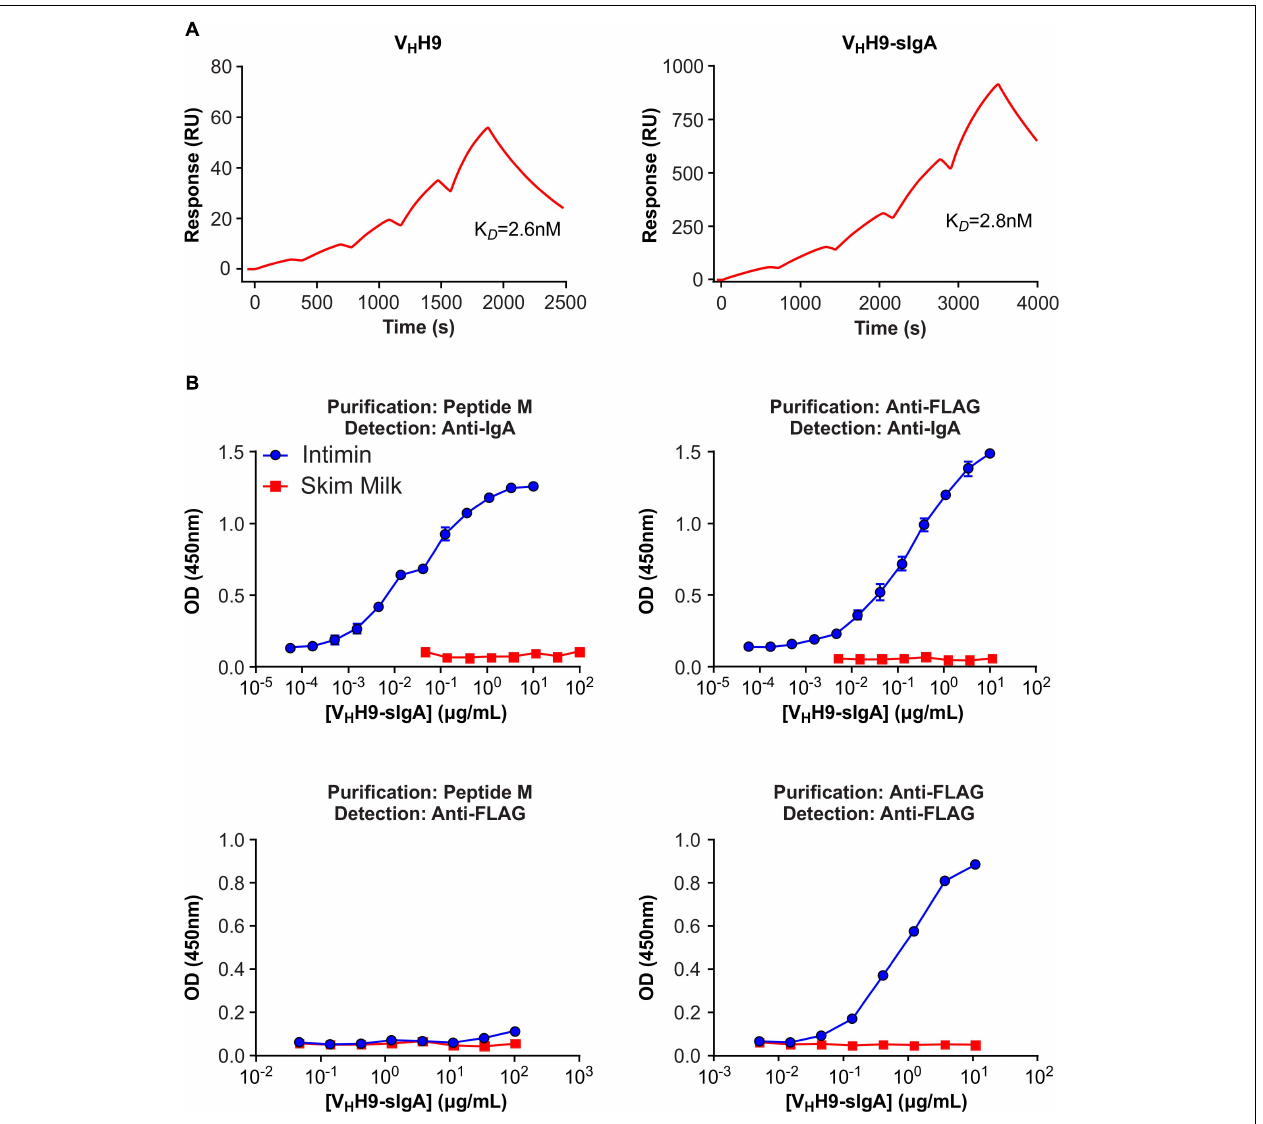
FIGURE 6 | Binding of plant-produced V H H9-sIgA to EHEC O157:H7 intimin. (A) SPR binding of V H H9-sIgA purified using peptide M. Either plant-produced V H H9-sIgA (top) or E. coli -produced V H H9 monomer (bottom) was immobilized on CM5 Series S sensor chips via amine coupling and MBP-Int277 was flowed over the resulting surfaces at concentrations ranging from 0.3 to 5 nM. The experiment was conducted in duplicate. Black lines show data and red lines show fits. (B) ELISA binding of plant-produced V H H9-sIgA purified using either peptide M (left) or anti-FLAG antibody (right) and detected using either anti-bovine IgA antibody (top) or anti-FLAG antibody (bottom). Results are representative of two independent